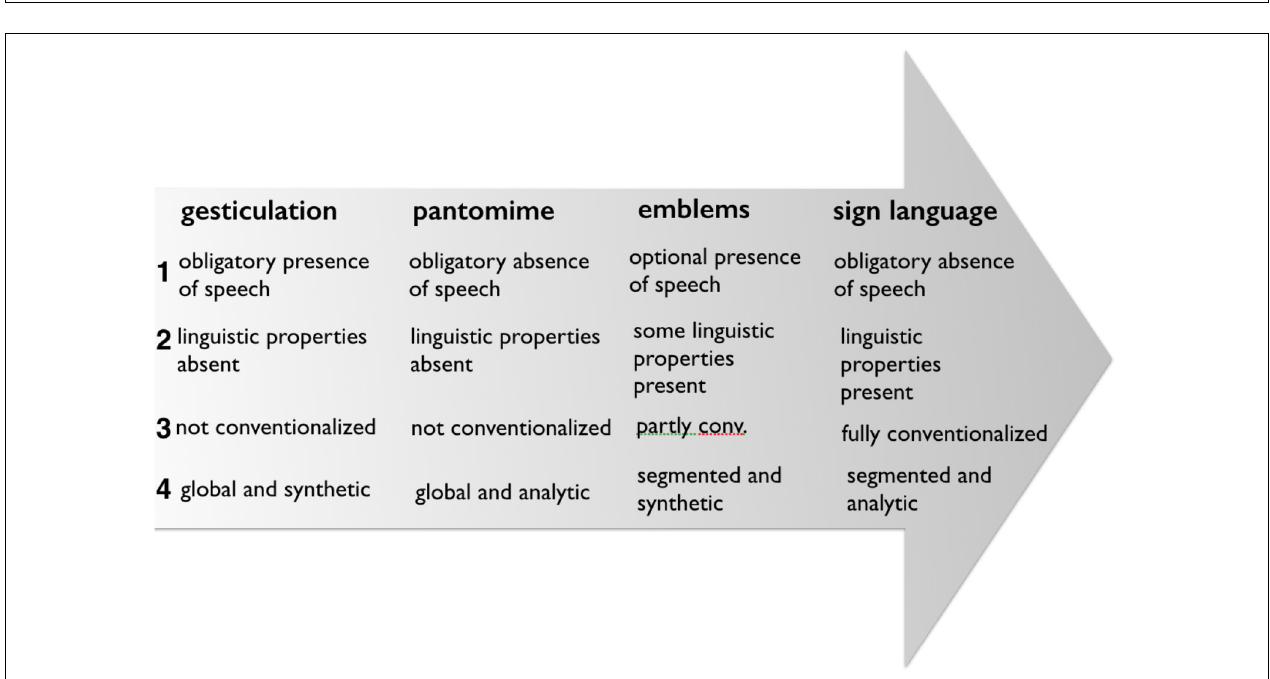
FIGURE 5 | McNeill’s (2000) expanded version of the gesture-sign continuum (adapted from McNeill, 2000, p. 1–10).